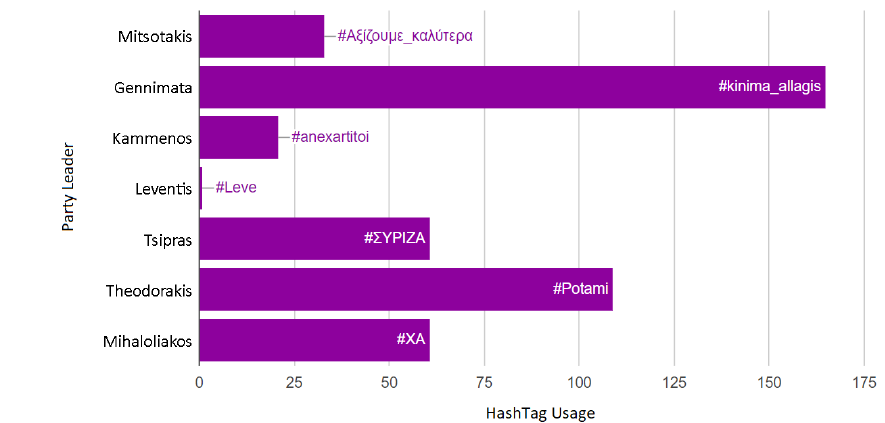
Figure 9. The top hashtag of each political leader.